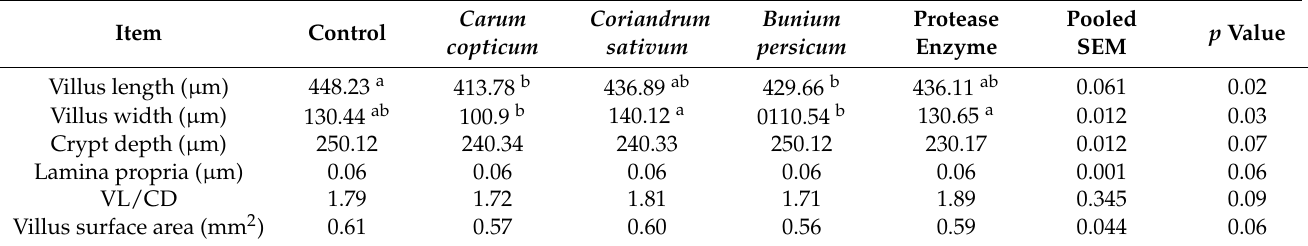
Table 5. Effect of adding herbal plant feed additives and protease in feed on ileum morphology in